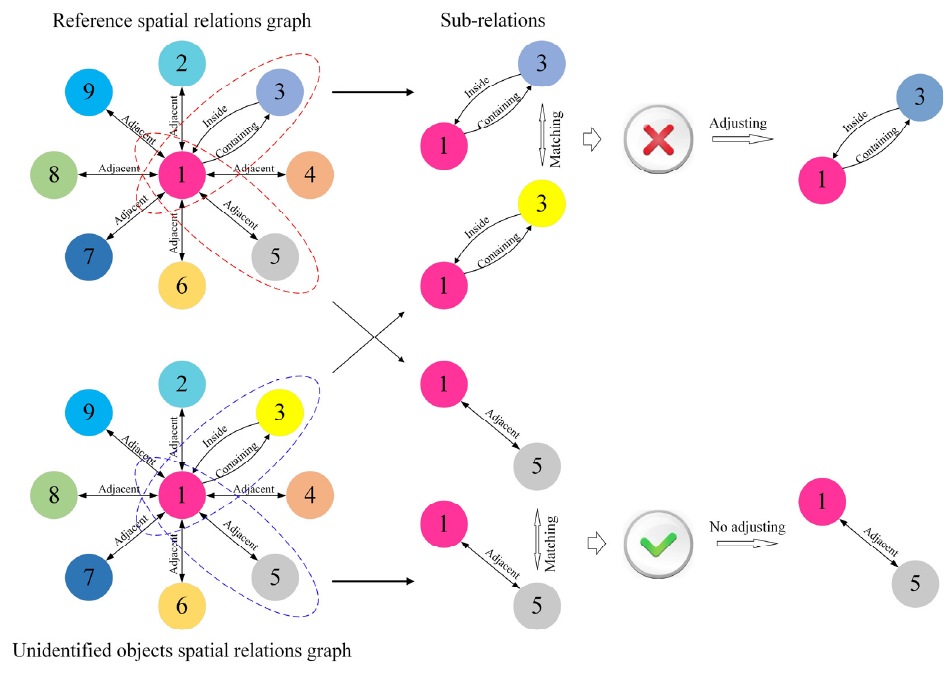
Figure 7. Process of comparing two spatial relation graphs. The colors represent the classes of objects, while the edges represent the spatial relationships between objects in the figure. √ indicates successful matching, while × indicates failed matching.